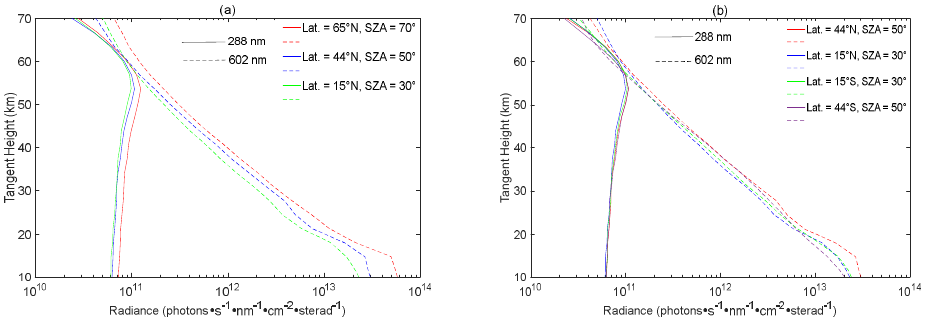
Figure 2. A sample of SCIAMACHY limb radiance profiles on orbit 49886 on 13 September 2011: ( a ) limb radiance profiles at different latitudes and corresponding SZAs in the northern hemisphere; ( b ) limb radiance profiles of the northern and southern hemispheres at the same latitudes and corresponding SZAs.